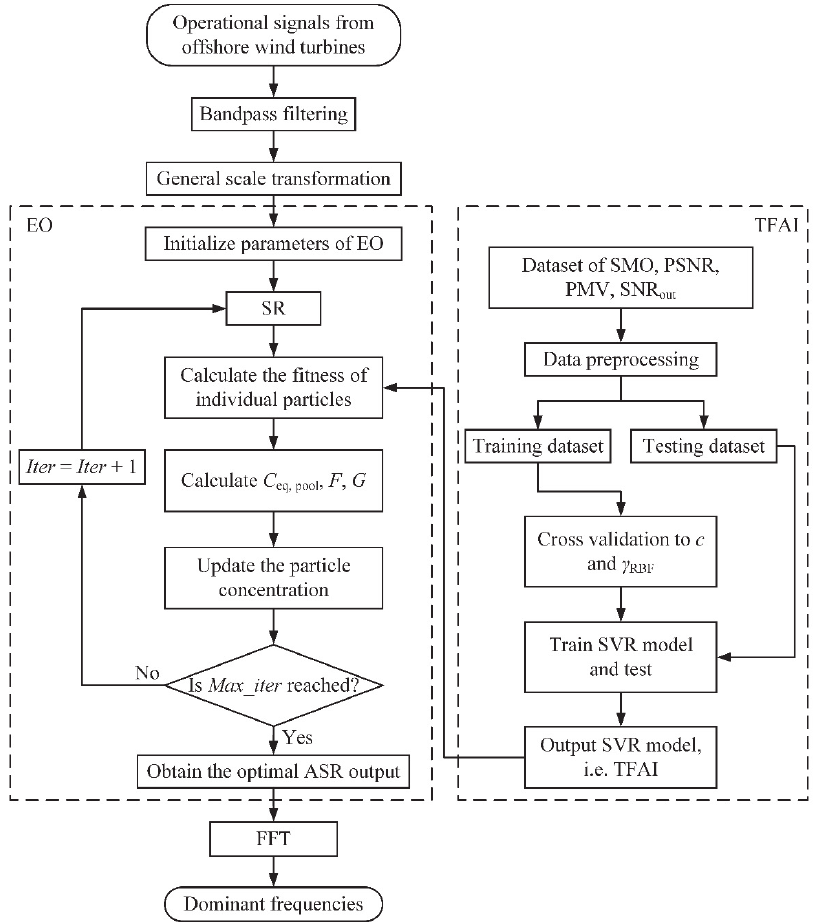
Figure 3. Figure 3. Flowchart of dominant frequency extraction of operational signals based on TFAI ‐ EO ‐ ASR method.